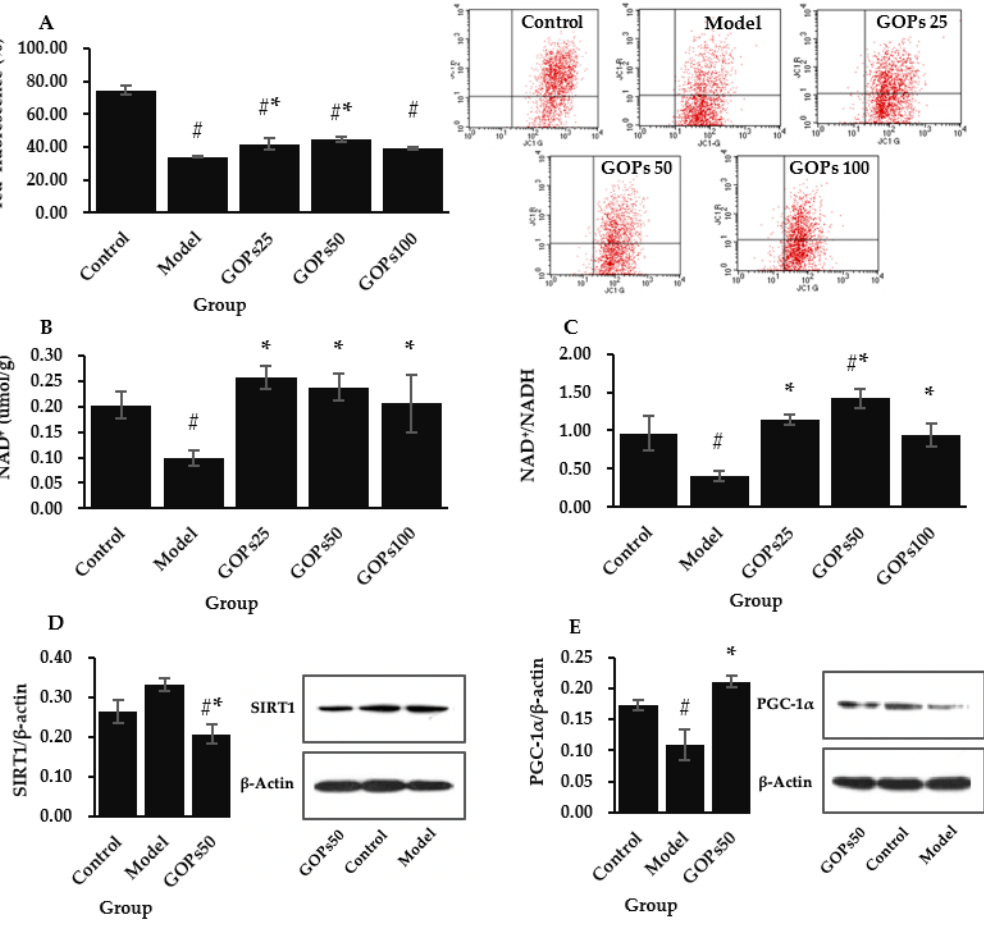
Figure 4. Effect of GOPs on mitochondrial function and biogenesis in NIH/3T3. ( A ) Effect of GOPs on the mitochondrial membrane potential; ( B ) Effect of GOPs on the NAD + levels; ( C ) Effect of GOPs on the NAD + /NADH; ( D ) Effect of GOPs on the relative protein expression of SIRT1. ( E ) Effect of GOPs on the relative protein expression of PGC-1 α . Values represented the mean ± S.D. ( n = 3 per group). # p < 0.05 versus control group, * p < 0.05 versus model group.